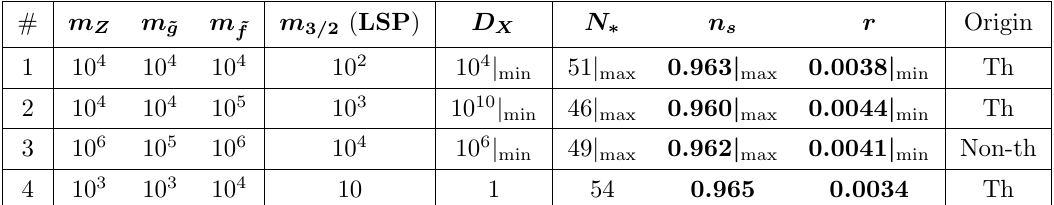
Table 1 . The n s and r prediction for gravitino LSP and a gauge mediation scheme for the R 2 supergravity model. In the cases # 1, 2 and 4 the gravitinos are produced from thermal scatterings of messengers and MSSM (cid:12)elds while in the case # 3 from the non-thermal decay of the supersymmetry breaking Z (cid:12)eld. In cases # 1, 2 and 3 dilution is required to decrease the LSP abundance below the observational bound. In the case # 4 non-minimal hidden sector features have been assumed. The masses are in GeV